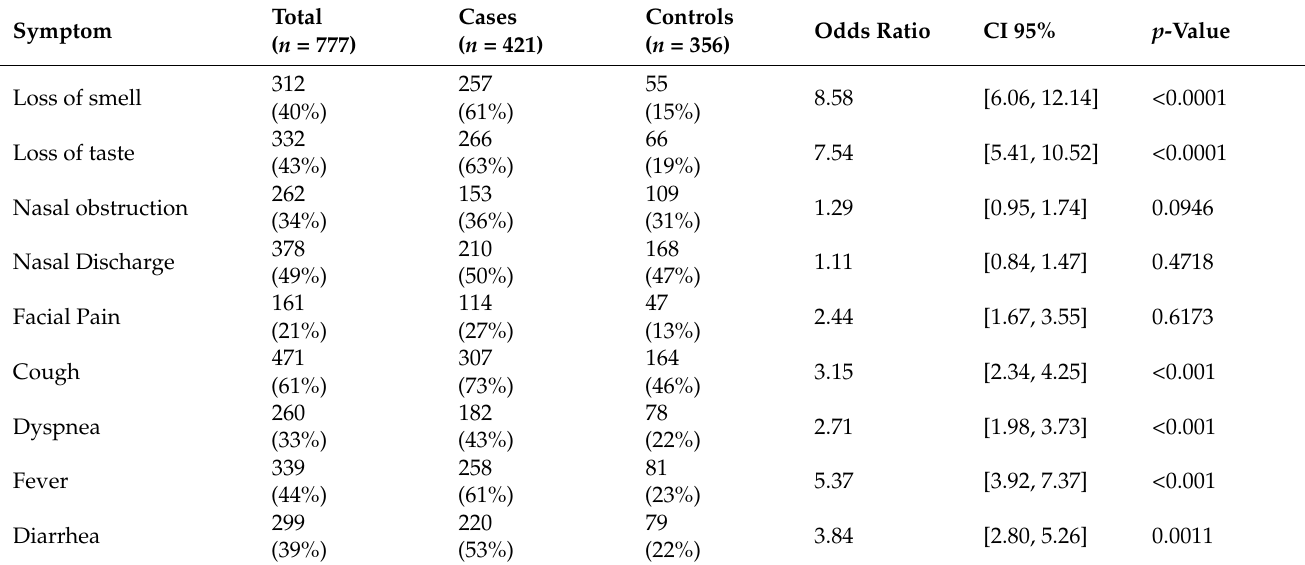
Table 1. Prevalence of symptoms in the sample. Odds ratios and 95% CIs values were calculated using the counts (%) in the table. p -values were calculated via χ 2 test.